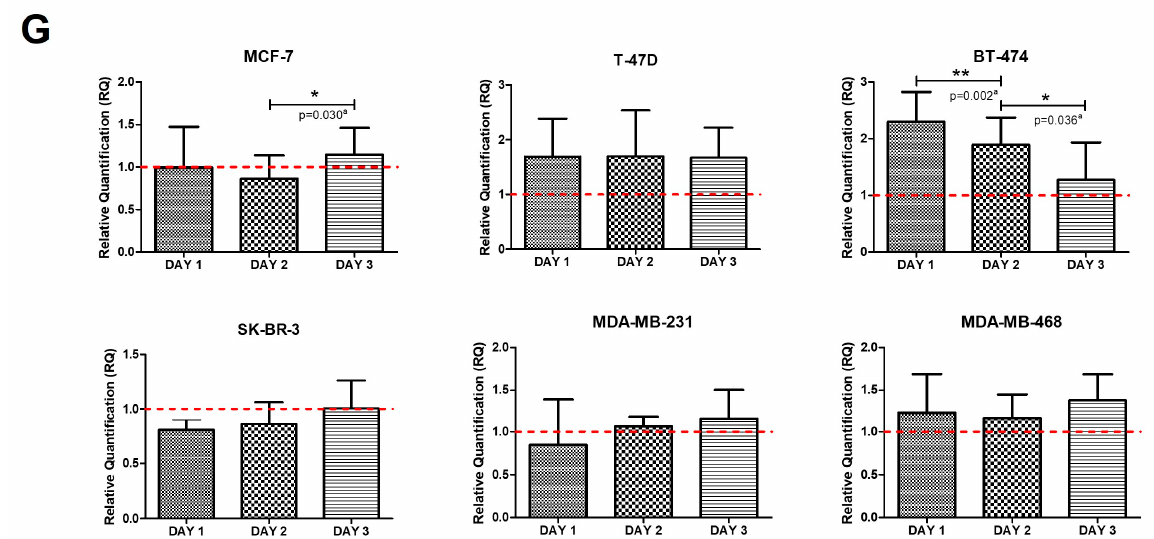
Figure 3. Relative mRNA quantification of ( A ) CTLA-4 , ( B ) PDCD1 (PD1), ( C ) CD274 (PD-L1), ( D ) PDCD1LG2 (PD-L2), ( E ) CD276 (B7-H3), ( F ) JAK2 , and ( G ) FoXO1 genes in co-cultures of breast cancer cell lines and PBMCs. All experiments were performed in triplicate. Each graph shows the three replicates’ mean value and standard deviation. * p < 0.05; ** p < 0.01 compared to the corresponding BC cell line (red line). a Student’s t -test for paired data; b Wilcoxon test. Similar results were observed for CD274 (PD-L1) and PDCD1LG2 (PD-L2), showing